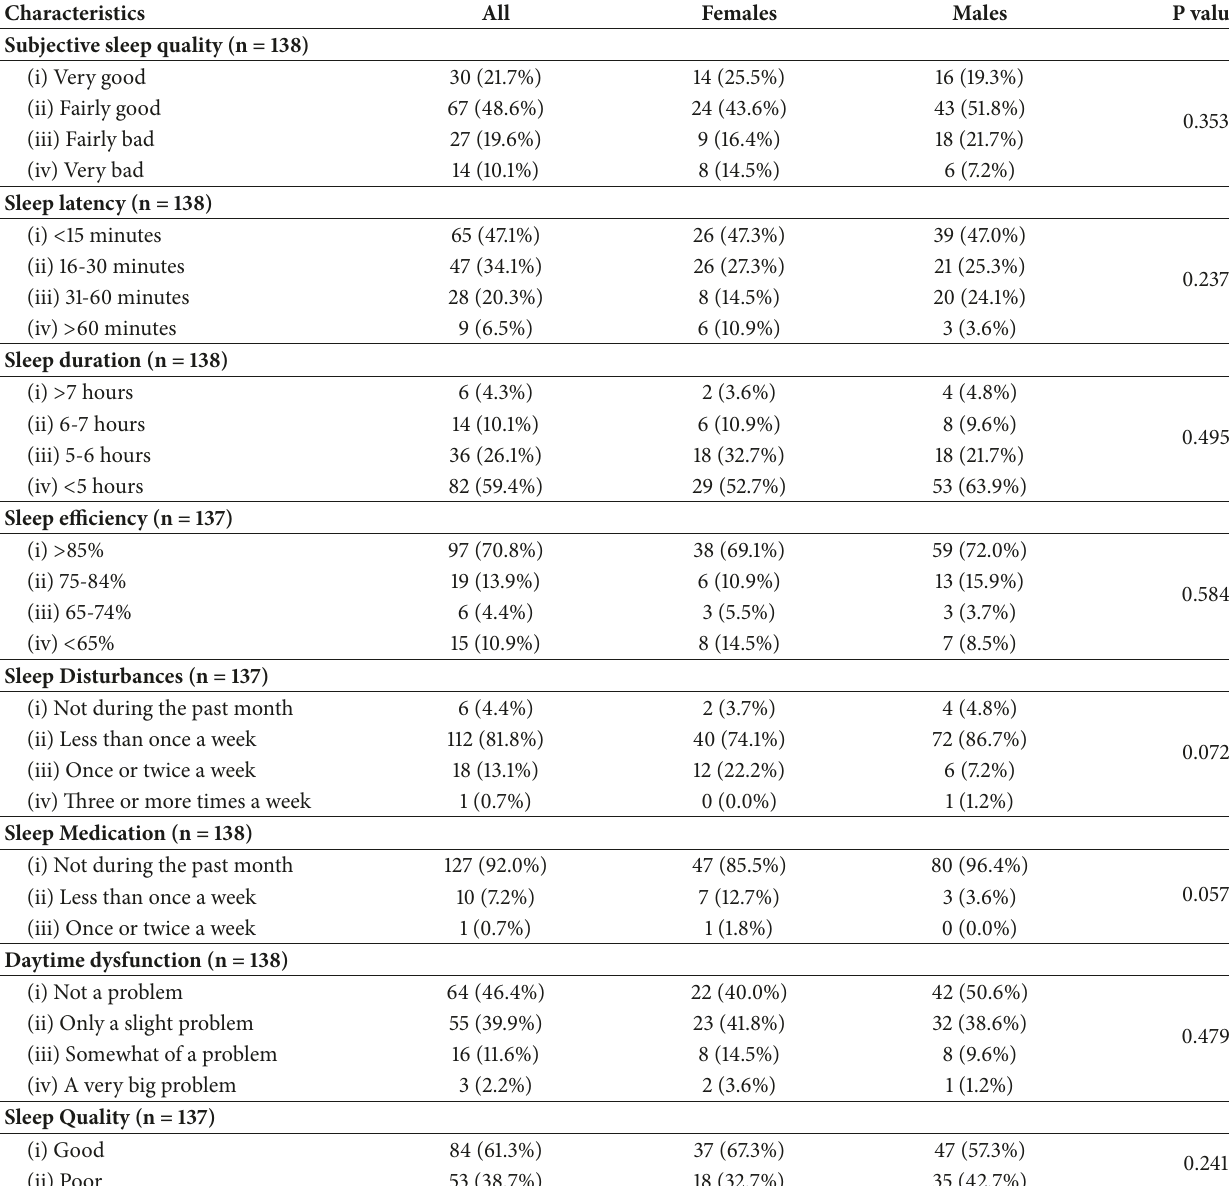
Table 2: Pittsburgh Sleep Quality Index components by